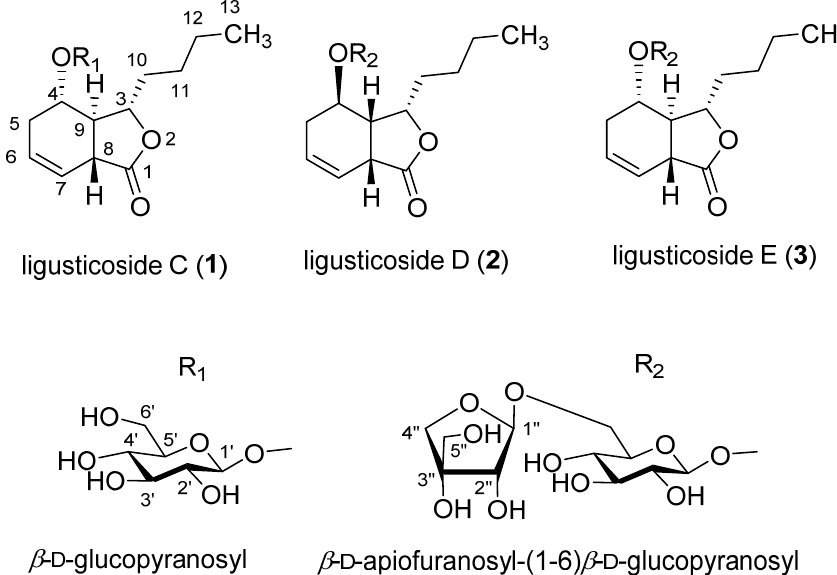
Figure 1. Key correlations in the 1 H- 1 H COSY ( — ) and NOESY ( ) spectra. G: β -D-glucopyra- nosyl; AG: β -D-apiofuranosyl-(1 → 6)- β -D-glucopyranosyl.